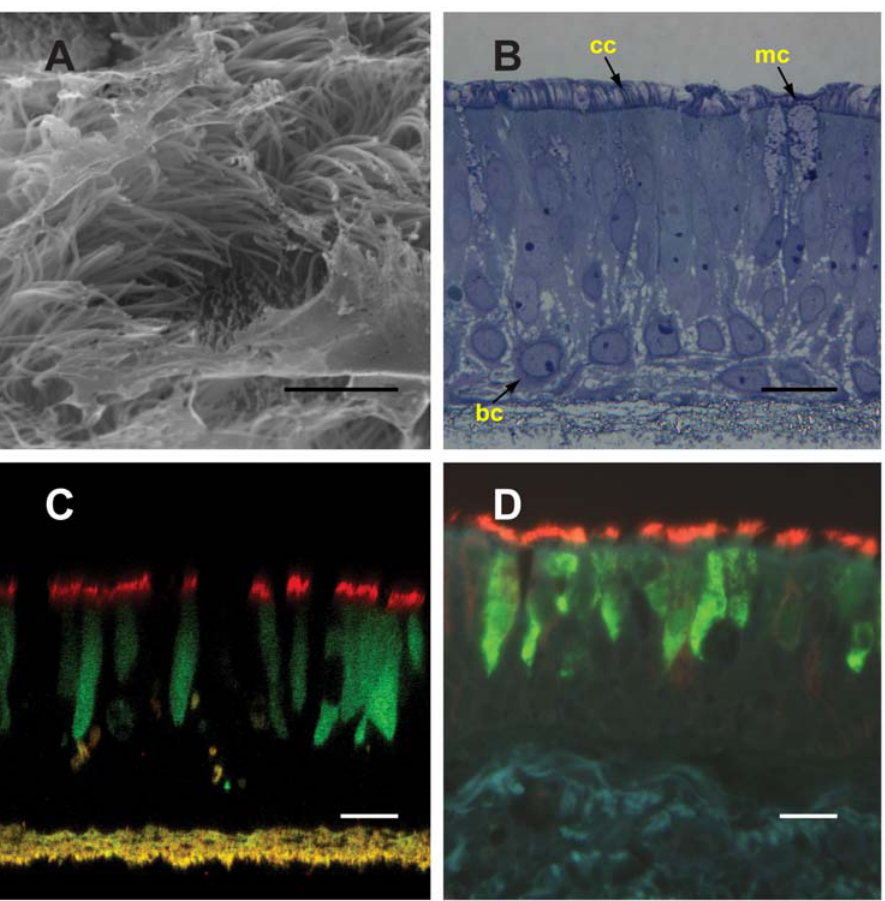
Figure 1. Infection of human ciliated cells by PIV in vitro and ex vivo. (A) Scanning electron micrograph of HAE showing cilia and mucus on the luminal surface. (B) Histological cross-section of HAE showing pseudostratified, columnar airway epithelium with ciliated (cc) and mucin-secreting cells (mc) and basal epithelial cells (bc). (C) Representative confocal XZ sections of HAE or (D) histological sections of human tracheobronchial tissue inoculated with PIVGFP (10 6 PFU) and GFP expression assessed at 24 h pi. GFP was detected by indirect immunofluorescence with rabbit anti-GFP polyclonal antibodies (Ab) and goat anti-rabbit IgG-fluorescein (green). Ciliated cells were identified using mouse primary Ab against acetylated a - tubulin and detected with anti-mouse IgG-Texas Red (red). GFP colocalized to cells that were also positive for acetylated a -tubulin, confirming the targeting of ciliated cells in vitro and ex vivo by PIV. Bar represents 20 m m in (A); and 5 m m in (B, C, and D).